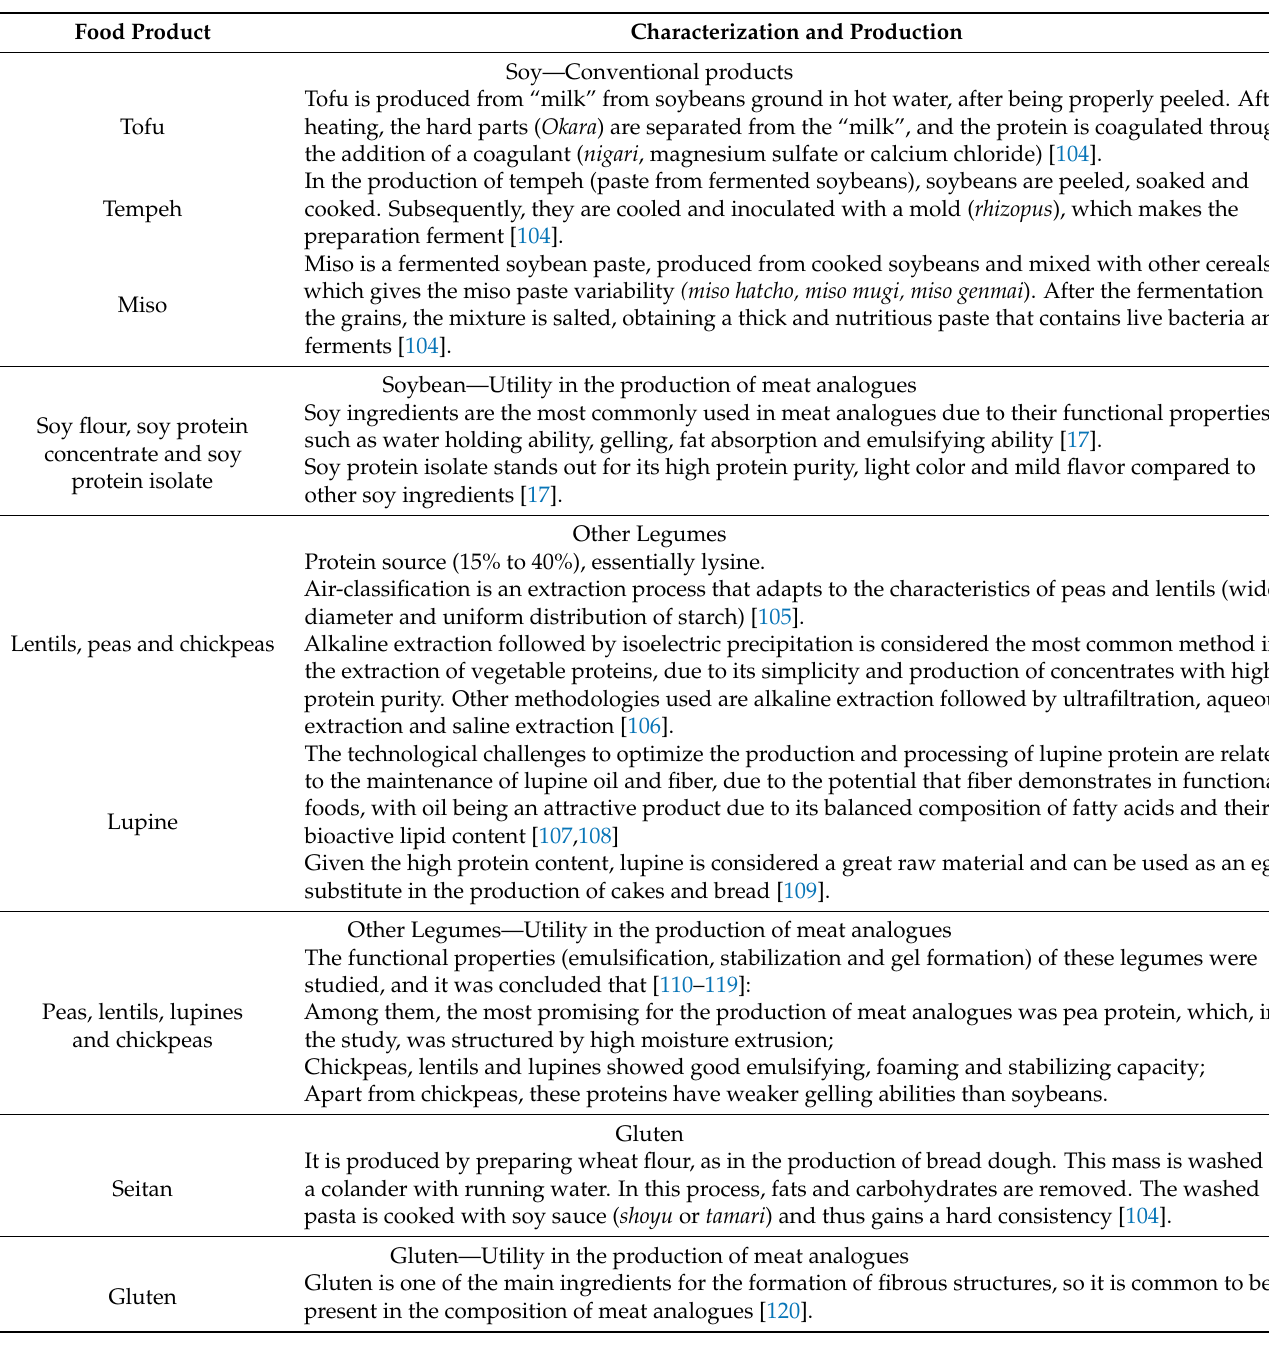
Table 4. Main sources of plant-based